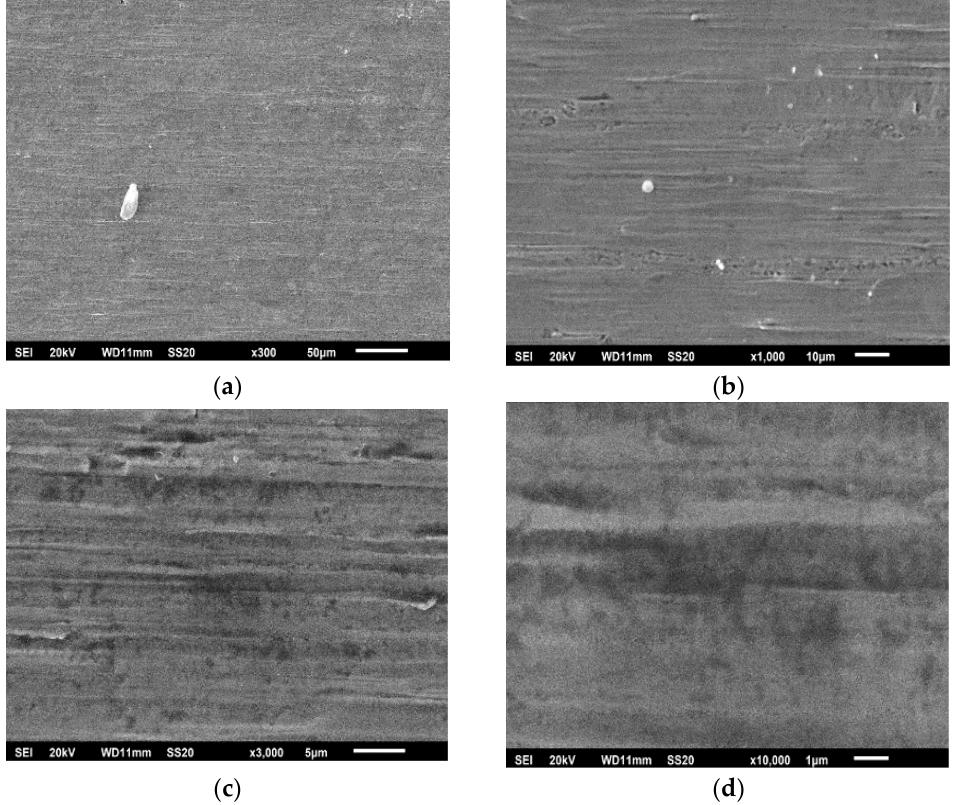
Figure 1. SEM images of the Fe-Cr-Al foil surface in the initial state at different magnifications: ( a )